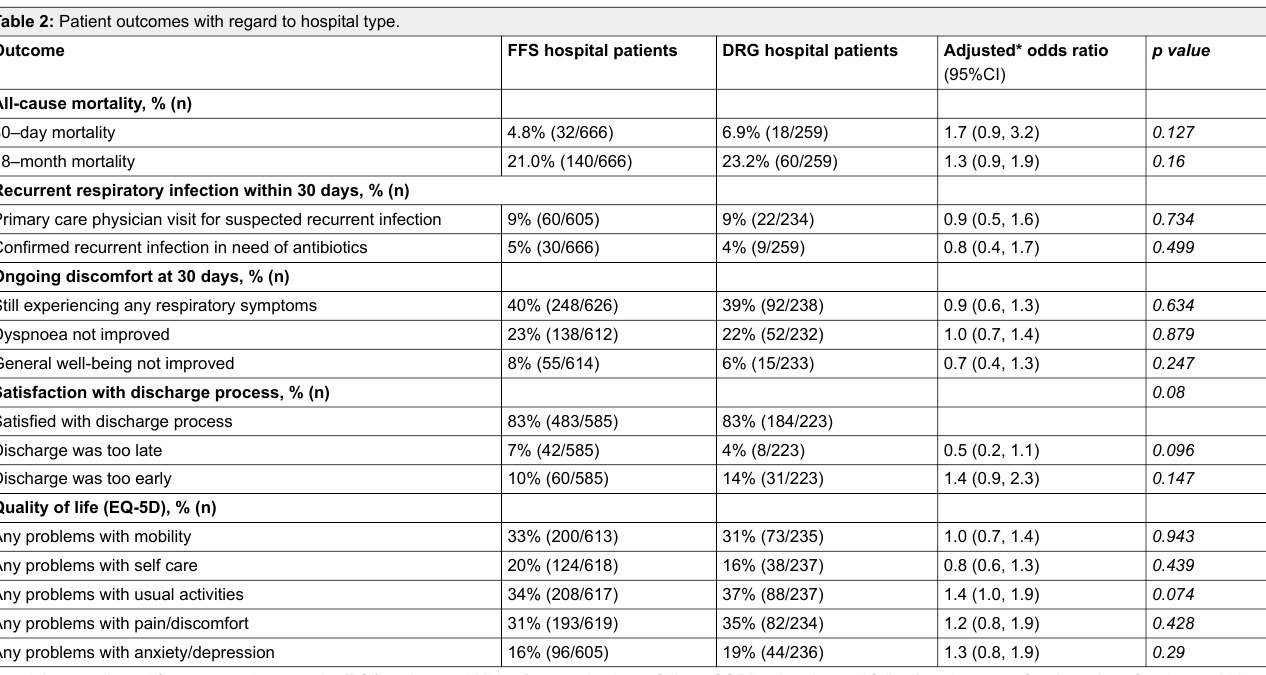
Table 2: Patient outcomes with regard to hospital type.